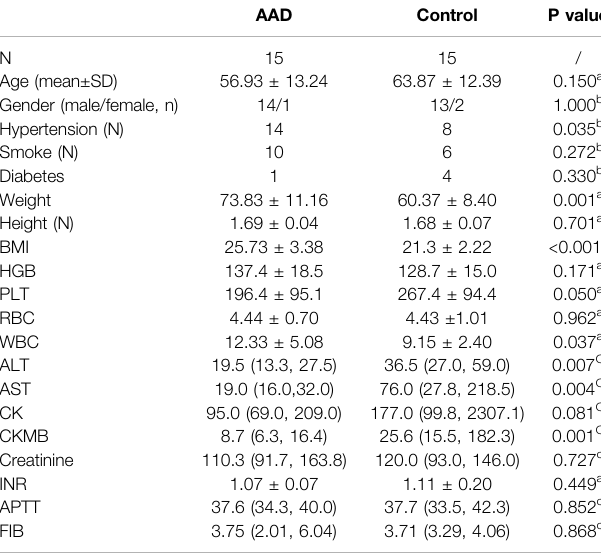
TABLE 1 | Clinical features of the iTRAQ, label-free analysis subjects.